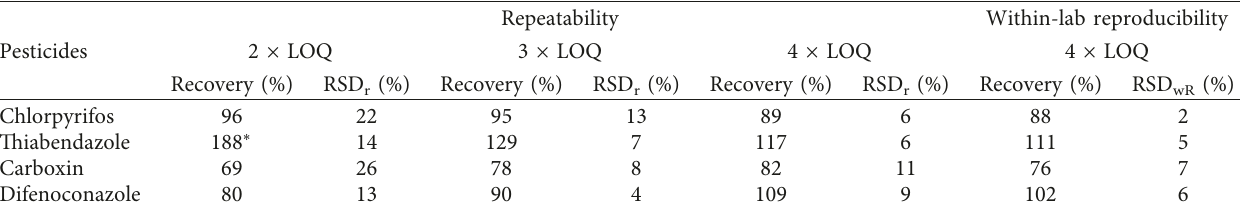
Figure 7: Analytical curves prepared by the external standard method and by the standard addition method for the compounds: (a) chlorpyrifos, (b) thiabendazole, (c) carboxin, and (d) difenoconazole. Table 3: Accuracy (% recoveries) and precision (repeatability and within-laboratory reproducibility) of the SLE-LTP method developed ( n � 5).